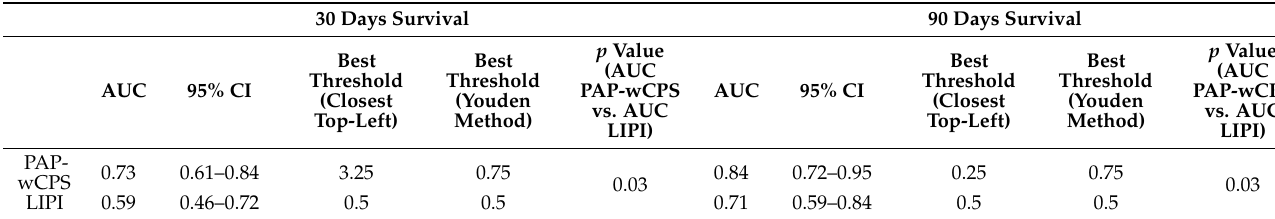
Table 2. Receiver operating characteristics (ROC) curves analysis.